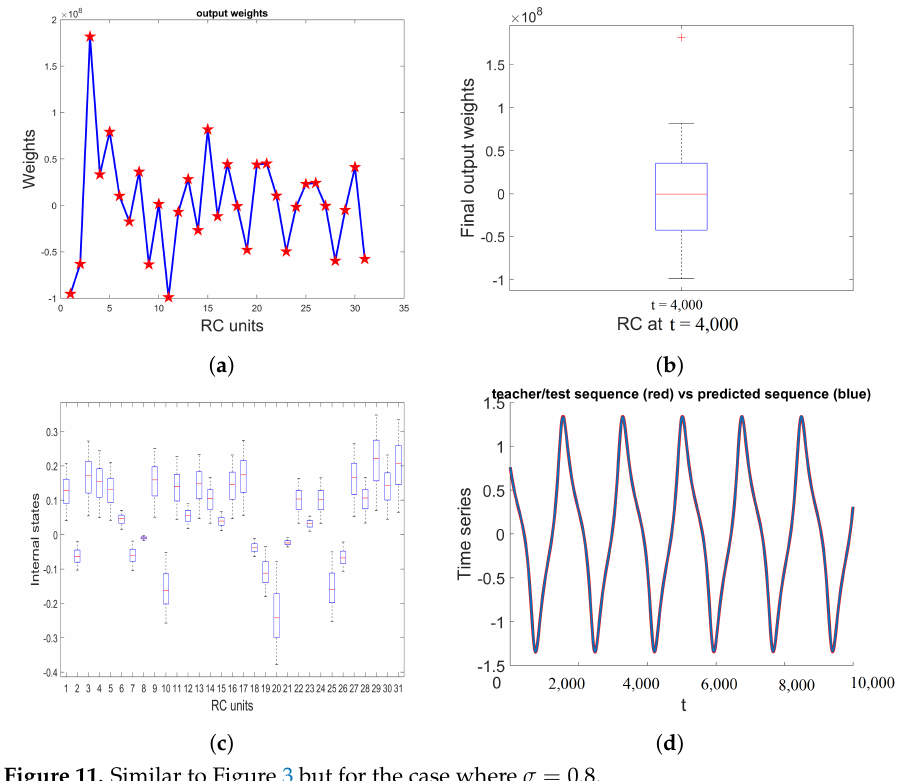
Figure 11. Similar to Figure 3 but for the case where σ = 0.8.